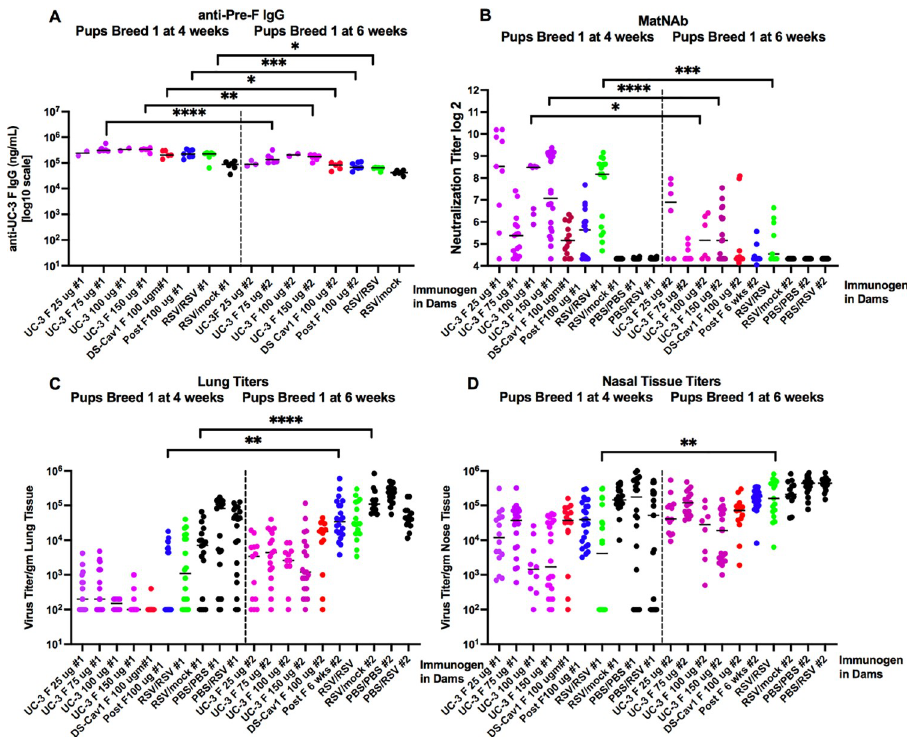
Fig 7. Durability of protection in breed 1 offspring. Sera and tissues acquired at 4 weeks or 6 weeks after birth of breed 1 pups were assessed for total anti-pre-F IgG (panel A), NAb titers (panel B), lung titers (panel C) or nasal tissue titers (panel D) after RSV challenge; Significant differences between matching groups (offspring of dams immunized with the same VLP at the same dose) at 4 and 6 weeks were identified by one way ANOVA followed by post-hoc Sıˆda´k multiple comparisons test � p < 0.05; �� p < 0.01; ��� p < 0.001; ���� p <